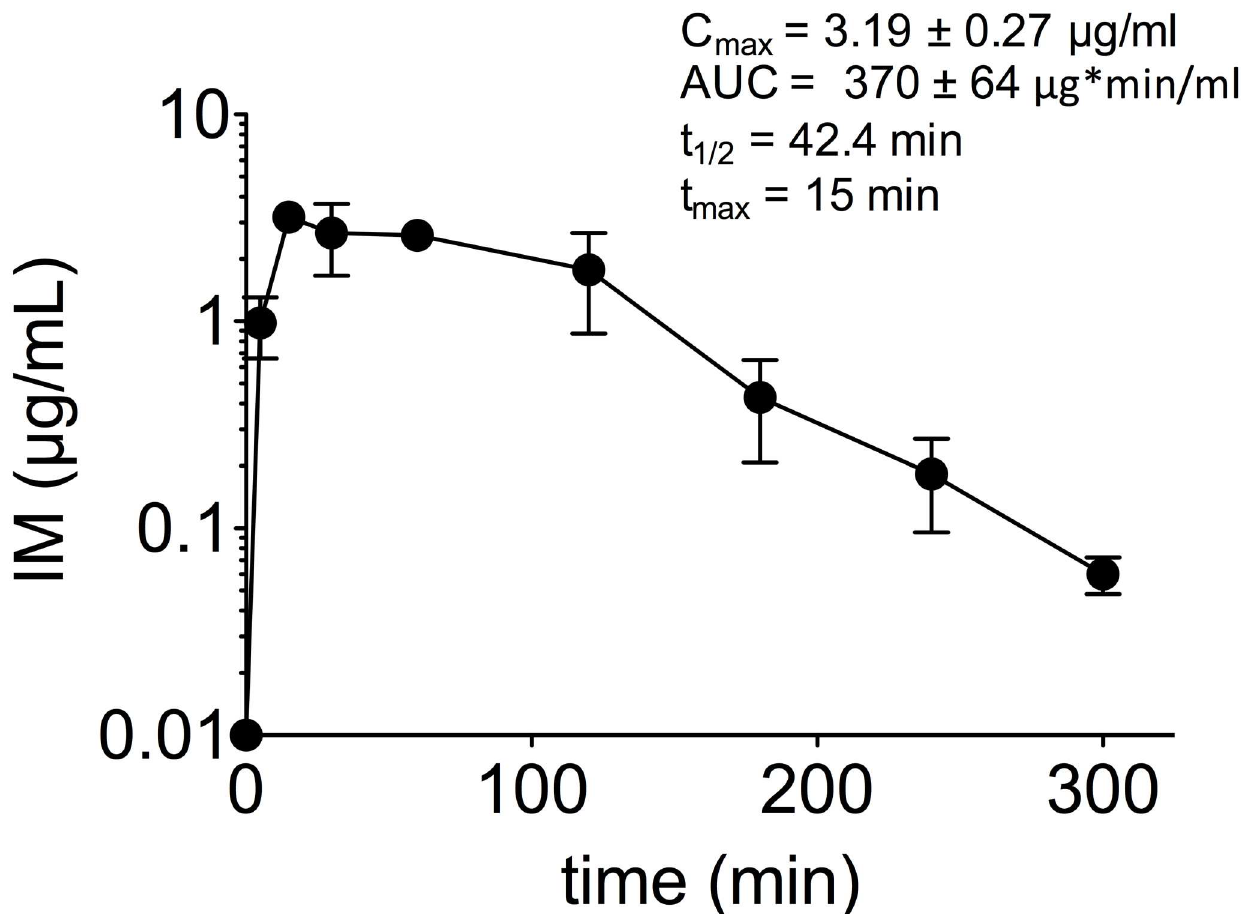
Fig 1. Pharmacokinetics of IM in mice. NSG mice (n = 16) were i.p. injectedwith 40 mg/kg IM. Blood sampleswere obtainedpre-doseand at 5, 15, 30, 60, 120, 180, 240 and 300 minutes after injectionusing a sparse samplingdesign(n = 2 samples per mouse, n = 4 samples per time point). Separatedplasma was further extracted and processedfor analysis,and IM concentrations were determined using HPLC analysis.